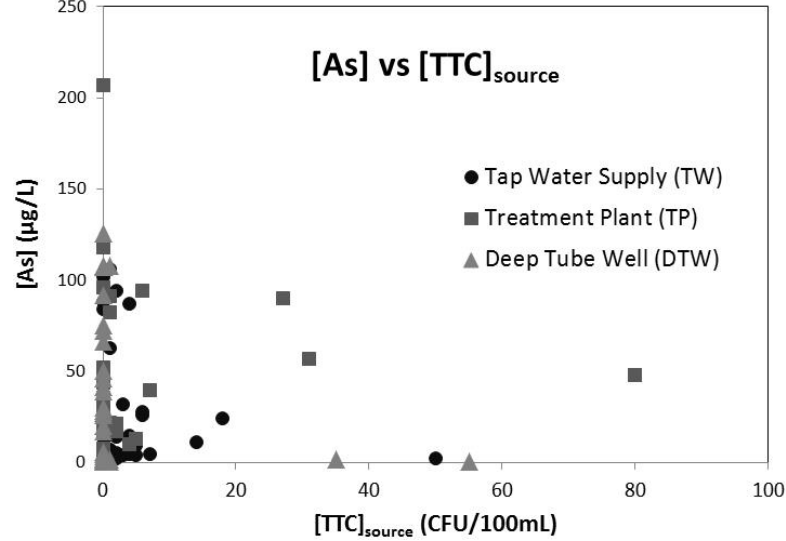
for any source for source